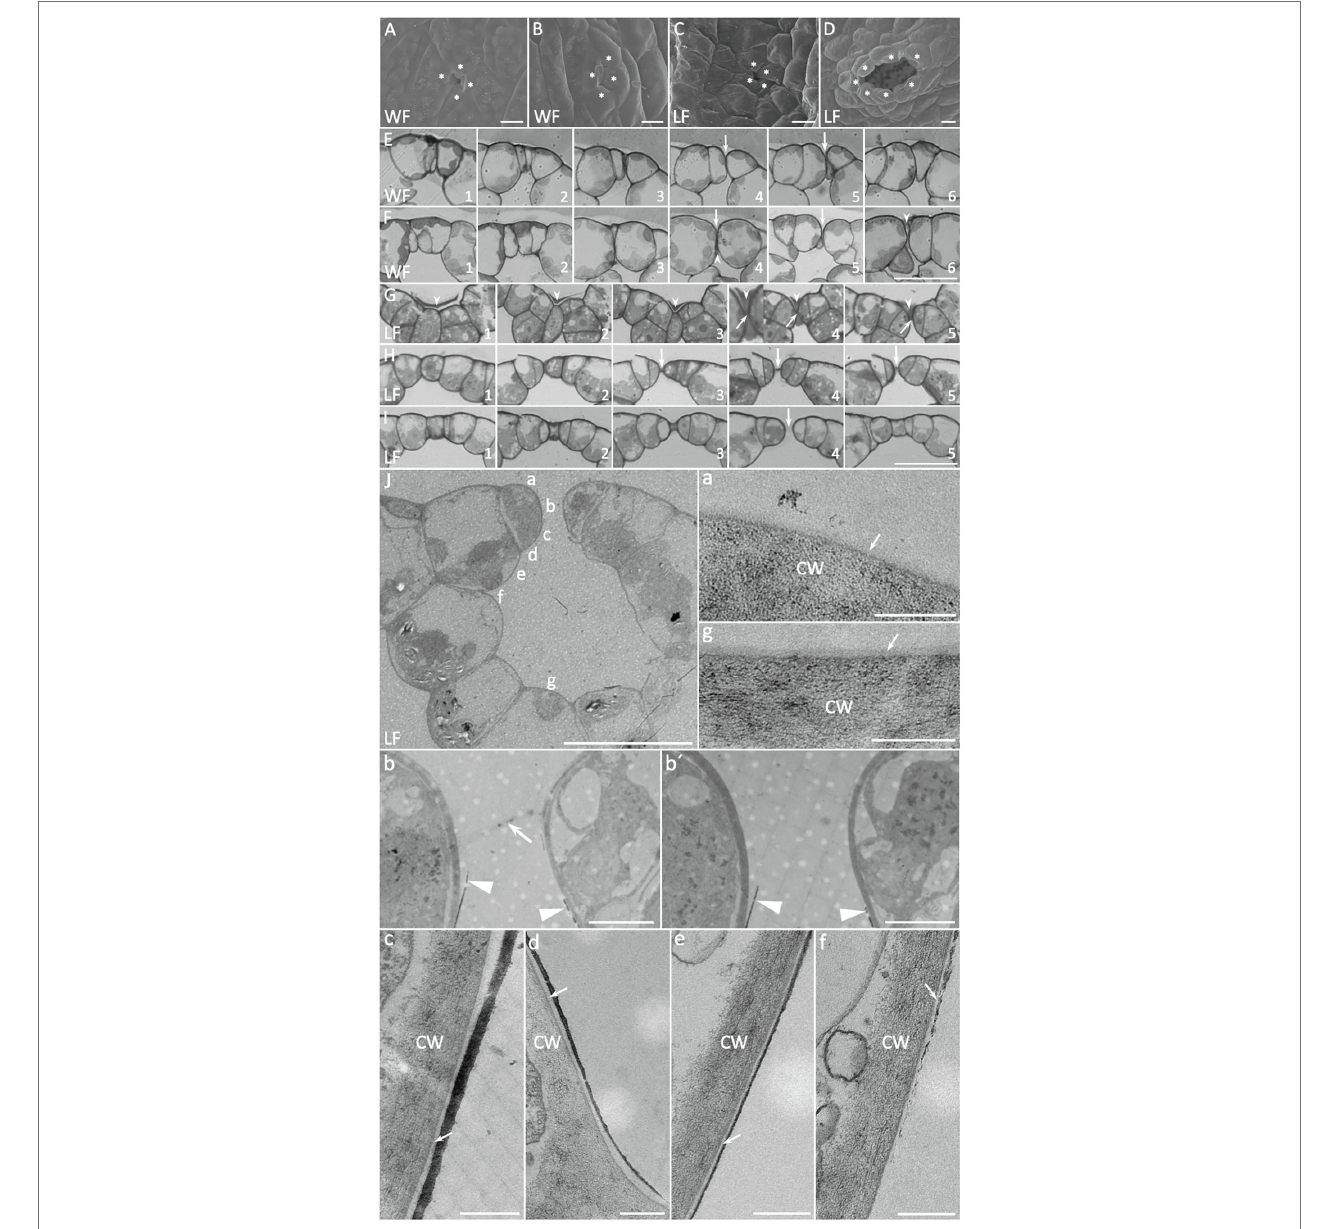
FIGURE 3 | Development of Riccia fluitans WF and LF air pores. (A , C) Young WF and LF air pore invaginations in the apical notch region are formed by four initial air pore ring cells. (B) Arrested older WF air pore in a posterior thallus region, covered by protrusions of two opposing pore ring cells, whereas (D) shows a mature LF air pore in the respective position. (E) Serial cross sections through an arrested WF air pore invagination (arrows), where rounded ring cells adjoin each other. (F) Cross section of four different (F1–F2, F3–F4, F5, and F6) arrested WF air pores. Arrowheads indicate extracellular plugs, occluding extremely narrow pore openings underneath pore invaginations (arrows). (G) Serial cross sections through a young LF air pore invagination reveal a darker extracellular mass (arrowheads) covering the pore invagination, where opposing pore ring cells are still connected by a thin bar-shaped structure (arrows) traversing a developing central pore. (H , I) Serial cross sections through an intermediate pore stage (H) and an open (I) LF air pore. The pore is still sealed by the bar-shaped structure in the median plain in ( H ; arrows) and already open in ( I ; arrow). (J) Cross section through a mature LF air pore and air chamber with cell wall and additional layer details, depicted in (a–g). (a,g) Show outer periclinal walls of a pore ring cell and a bottom air chamber cell, respectively, forming an additional layer on the cell wall, likely representing the cuticle (arrows). Arrow in (b) points to remnants of a bar-shaped structure still spanning the pore, similar as observed in H4, which is absent in another serial section of the same pore cut in a median plane (b ′ ). A massive dark layer, likely representing epicuticular waxes is deposited on the lower part of the anticlinal pore ring cell walls, facing the pore (b,b ′ arrowheads) and sometimes detaches at the tip. (c–f) Show the progression of the layer along the pore ring cells toward the inner lumen of the air chamber. Arrows point to the cuticle between cell walls and wax layer. Pore ring cells are marked by asterisks according to probable cell borders. Scale bars: (A–C) 10 μ m; (D) 20 μ m; (E–I) 25 μ m; (J) 20 μ m; (J) a,c–g 200 nm; and (J) b,b ′ 2 μ